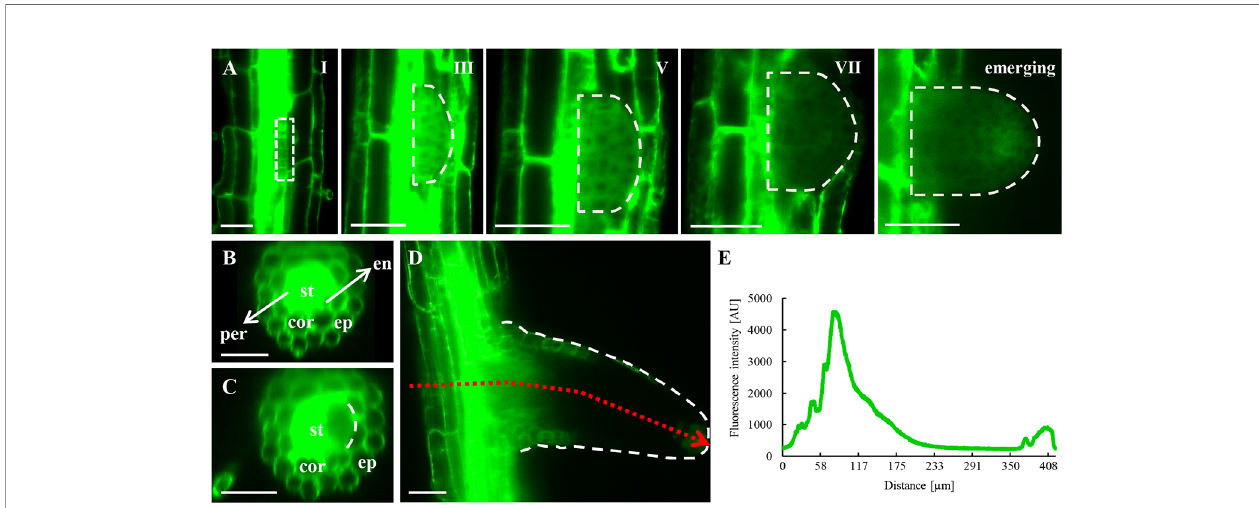
FIGURE 5 | In vivo localization of ANN1-GFP during lateral root formation and emergence in transgenic A. thaliana expressing proANN1::ANN1:GFP construct using LSFM. (A) Representative images of selected developmental stages of lateral root primordium (LRP) establishment. ANN1-GFP signal was localized in the cytoplasm and was absent in nuclei of LRP cells in early stages of LRP formation (phases I, III, and V). ANN1-GFP signal considerably decreased in LRP cells in the phase VII and during lateral root emergence. (B) Cross-section of the primary root from orthogonal projection before LRP initiation with the strong and uniformly distributed signal of ANN1-GFP in the stele (st) and decreased amount in vacuolated cells of endodermis (en), cortex (cor), and epidermis (ep). (C) Drop of the ANN1-GFP signal intensity in the pericycle and adjacent stele tissue at the time of LRP establishment. (D) Distribution of ANN1-GFP signal in the emerging lateral root. Tissue-speci fi c fl uorescence intensity in emerging lateral root was determined along the pro fi le representing a cross-section of the primary root and longitudinal gradient in developing lateral root (as shown by dotted red arrow). (E) The fl uorescence intensity along the pro fi le shown in (D) . Scale bars = 50 m